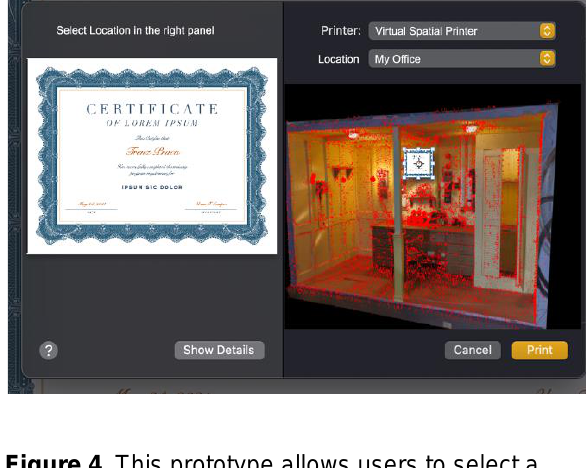
Figure 4. This prototype allows users to select a position for placing the virtual document in a scanned